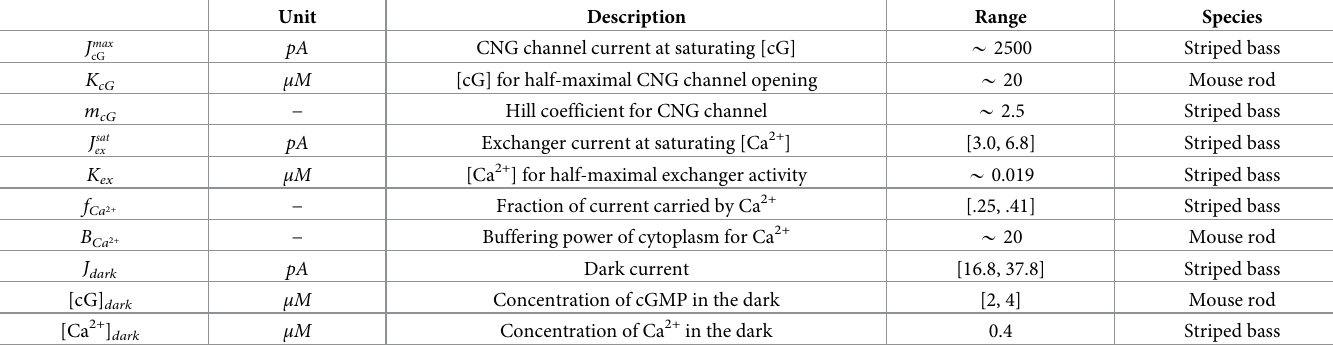
Table 5. Parameters for ionic currents of cone outer